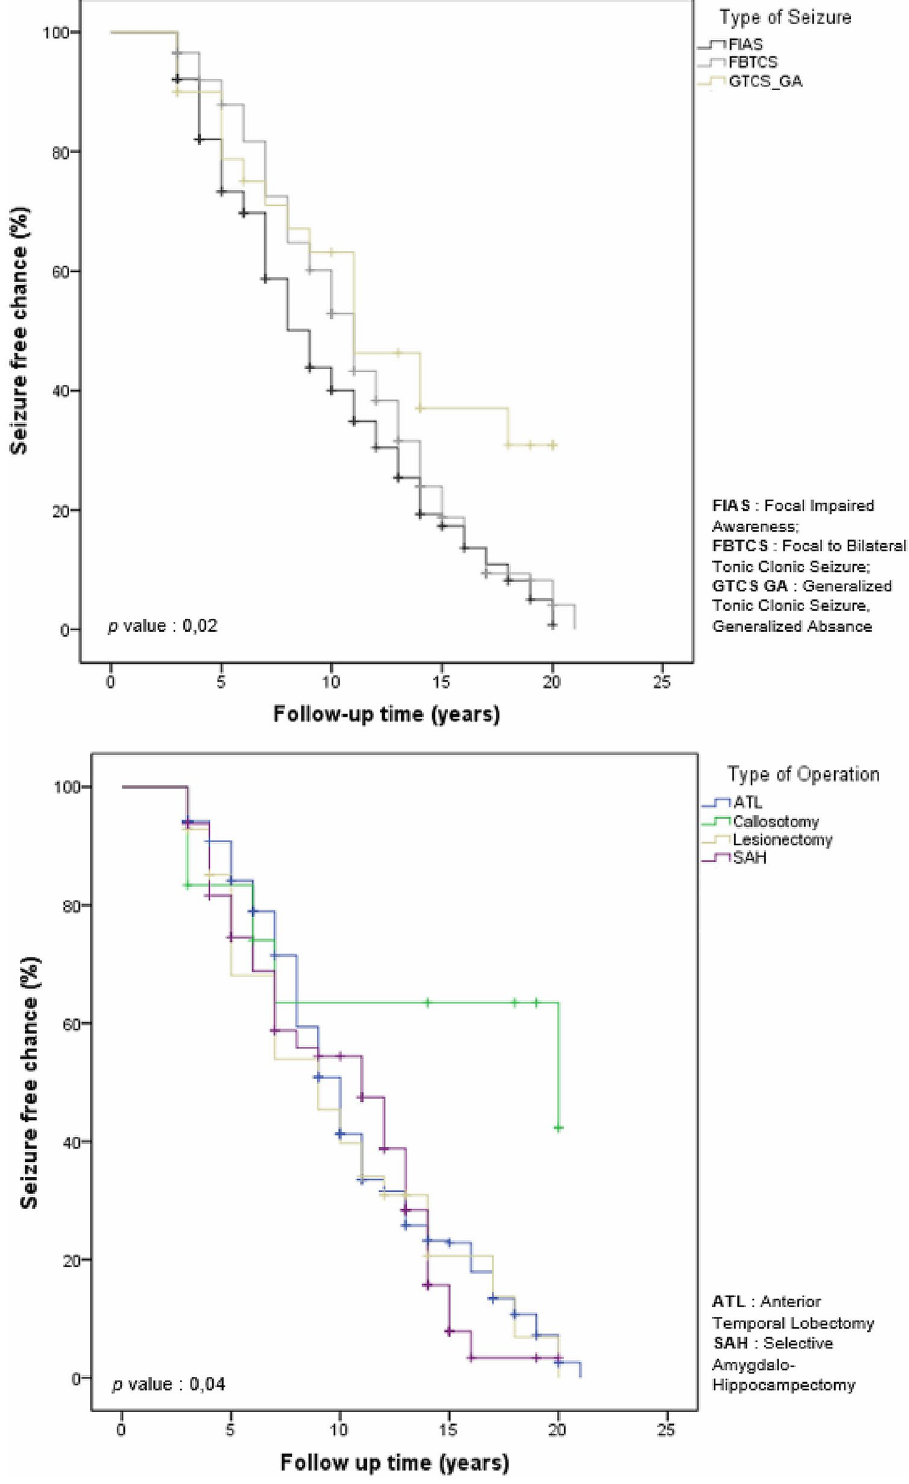
Figure 2. Kaplan–Meier plot predicting the chance of being seizure free at the end of follow-up. There were significant differences in the type of seizure and type of operation ( p = 0.02;